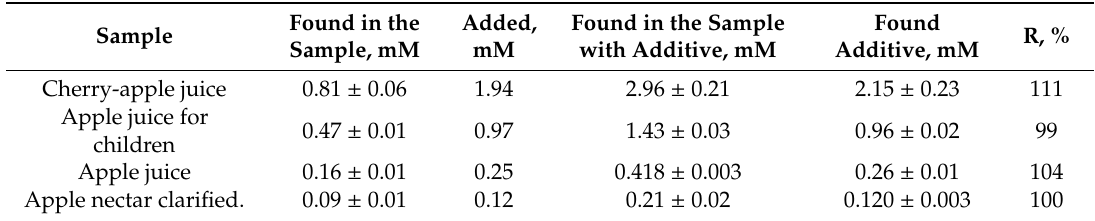
Table 4. Results determination of AA in fruit juices using the proposed sensor Au-gr / CVE (n = 3, P = 0.95).